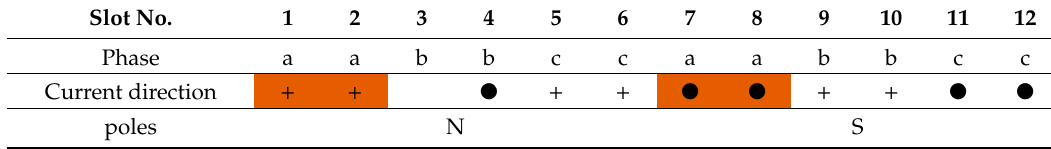
Figure 2. The wiring and magnetic field distribution of traditional winding, traditional toroidal winding, and 120 ◦ phase belt toroidal winding. Table 2. 12 slot winding currents for traditional winding solid rotor induction motor.